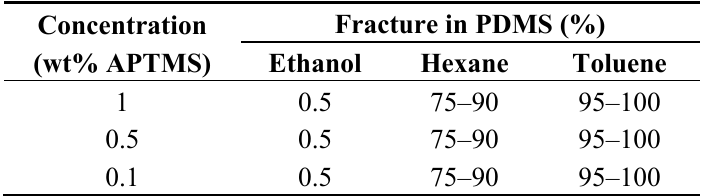
Table 1. Effect of solvent on SU-8–PDMS bonding using three different APTMS